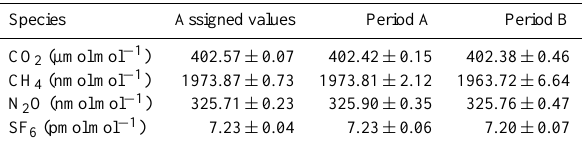
Table 4. Assigned target gas values with the respective mole frac- tions measured using the GC system at the Puy de Dôme station over period A and period B. The assigned values were measured by the GC system at the LSCE central lab against WMO calibration gases.